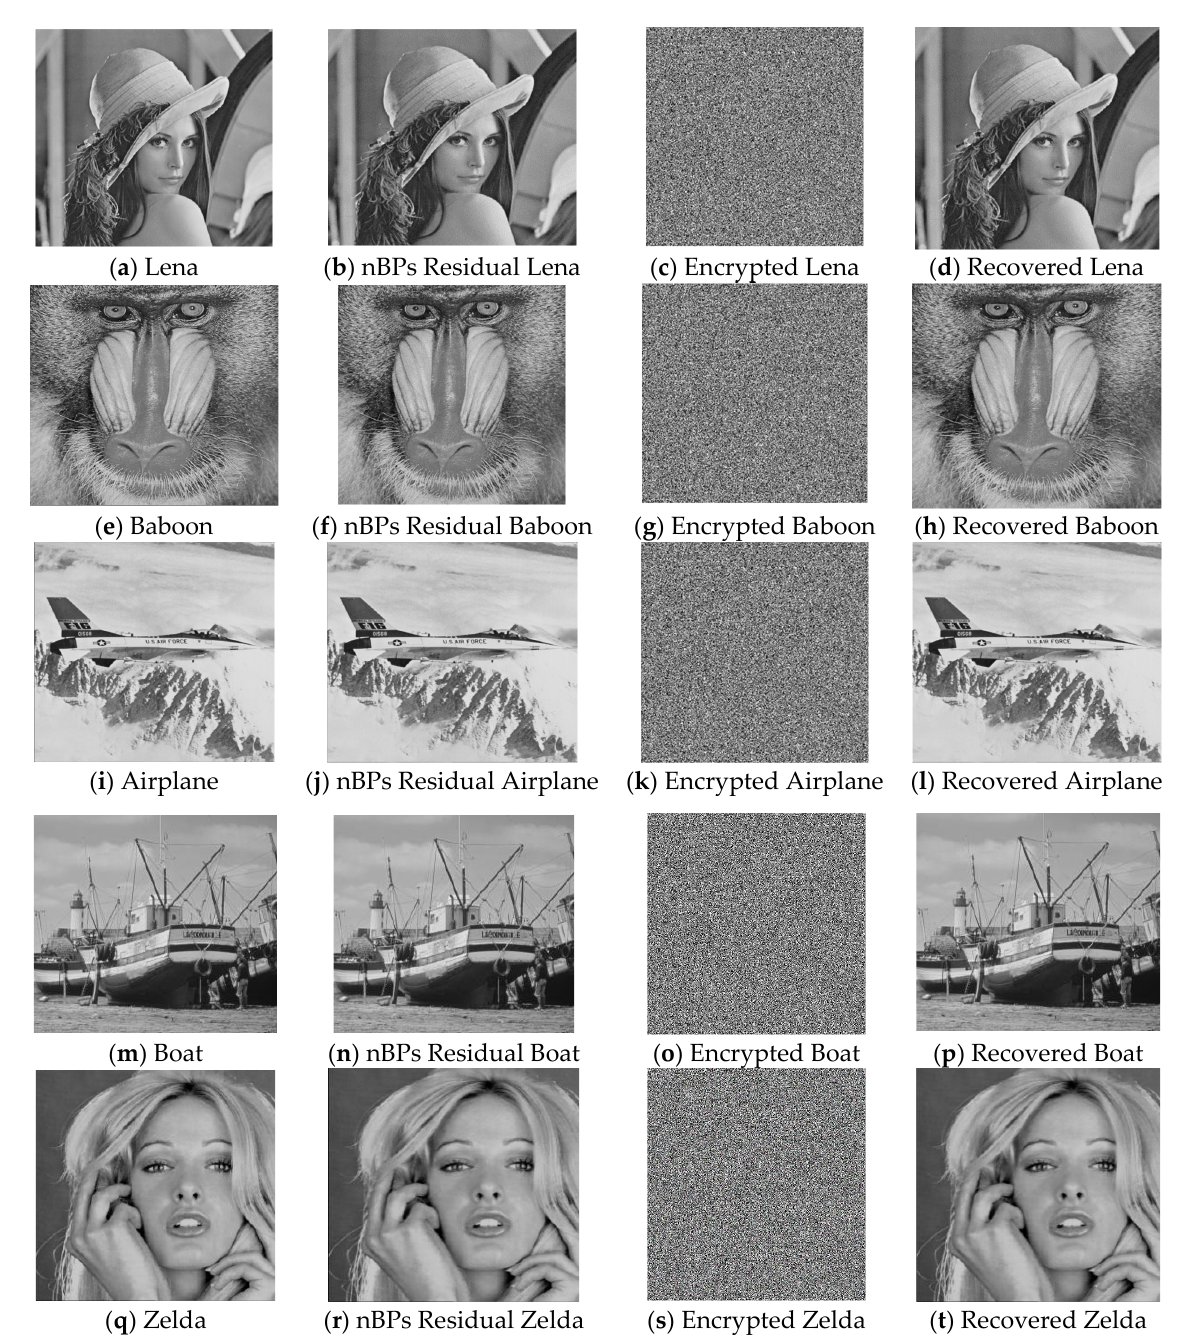
Figure 8. Cover, nBPs residual stego-image, encrypted image and the recovered/decrypted images of sizes 512 × 512 .